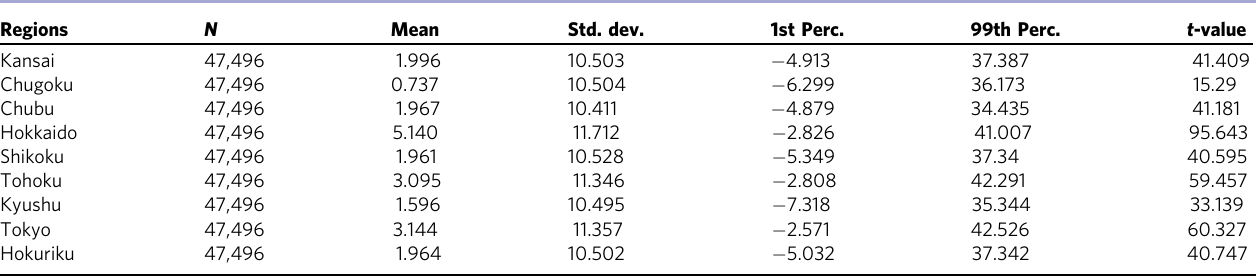
Table 1 Summary statistics of electricity price in each region. Regions N Mean Std. dev. Kansai